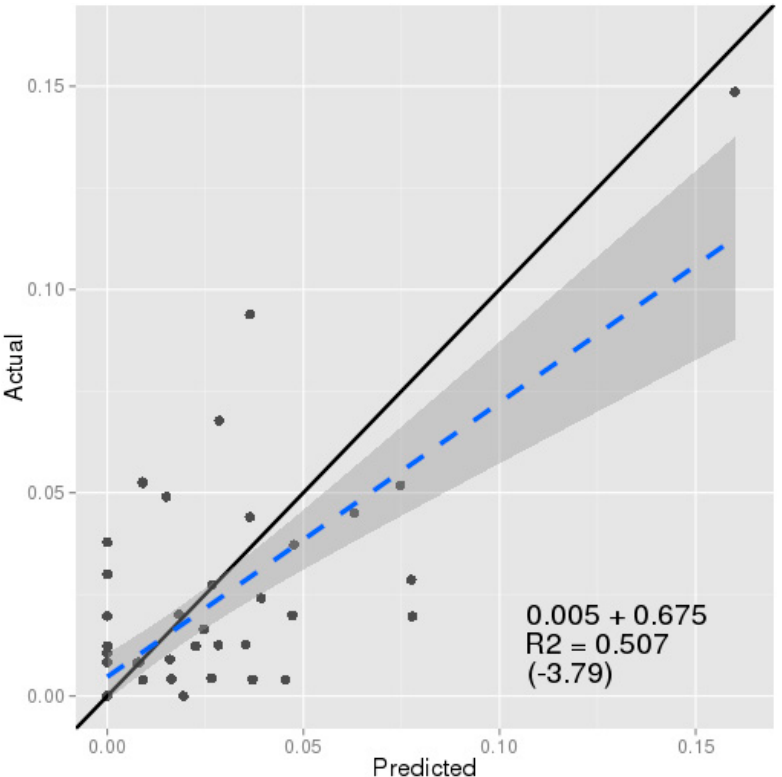
Figure 5. Predicted versus actual outage rates for inhabited locations. Observations of predicted and actual outage rates ( black dots ), with 45-degree line ( solid ), best-fit regression line ( dashed blue ), 95% confidence interval ( grey shade ), regression results, and Student’s t -test statistic for equality of slope to 1 in parentheses.